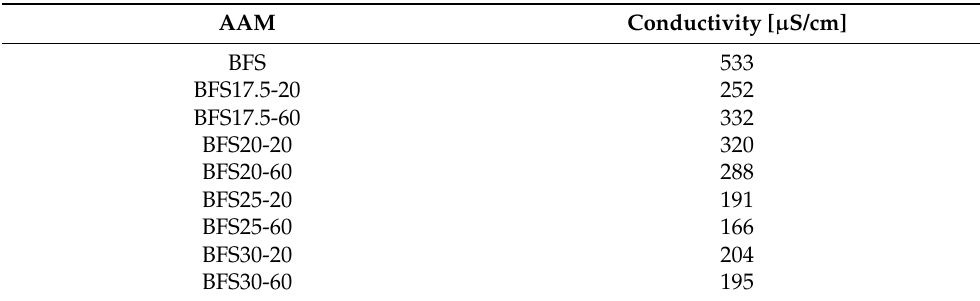
Table 1. Conductivity of aqueous solutions after 4 h at 150 ◦ C under an N 2 atmosphere of 2 MPa and AAM concentration of 4 g/dm 3 .